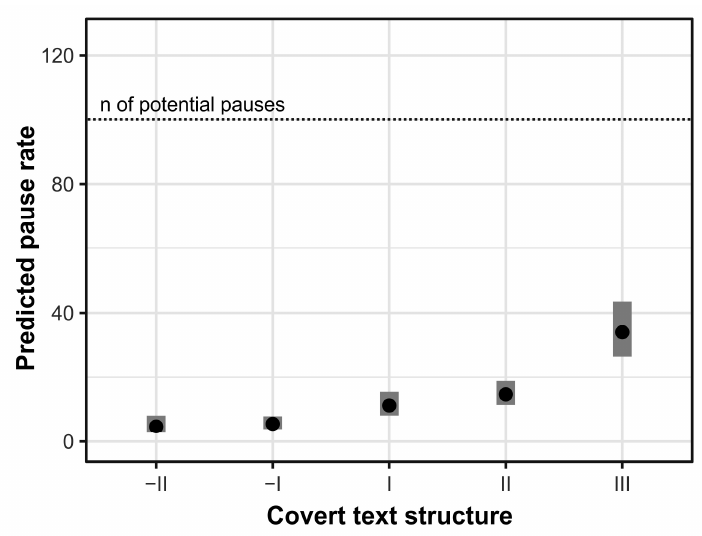
Figure 7. Predicted pause rate as a function of the grammatically informed analysis according to Franz et al. (2022). For an explanation of levels, see Section 2.3. The predictions of a Poisson regression model are back-transformed from log values to rates and relate to a sample of 100 potential pauses (dotted line).